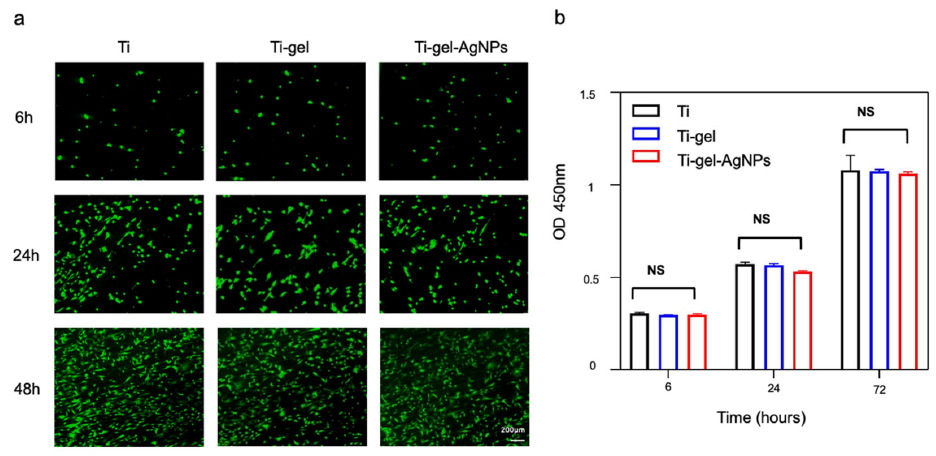
Figure 7. MSCs fluorescence imaging ( a ) and viability ( b ) after co ‐ cultured with Ti, Ti ‐ gel, Ti ‐ gel ‐ AgNPs for 6 h, 24 h, and 72 h. NS means no